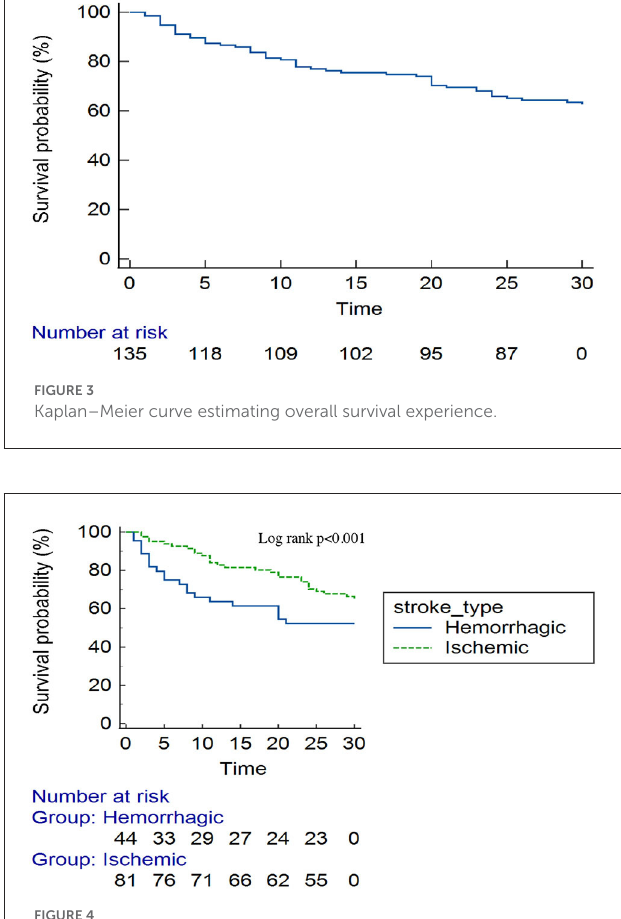
TABLE 5 Predictors of 30-day